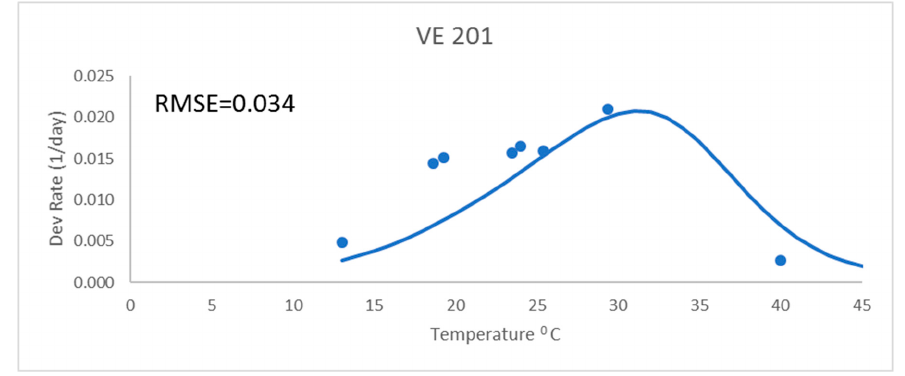
Figure 1. Poikilotherm equation with original parameters from Lehenbauer’s maize coleoptile elongation rate data, applied to the first variety (VE 201). RMSE indicates the root-mean-square error for the maize variety’s development rate. Table 2. Results with root-mean-square error (RMSE) for the published equations of Tonnang et al. [2] (Briere), with the Poikilotherm (Pk) equation [11] fit as described herein, for the heat stress equation fitted for just the first variety (Htstr), and for the heat stress fitted separately for each variety (Indiv fitted); also shown are Akaike’s Information Criterion (AIC), AICc, AICc differences ( Δ j AICc), and the derived Akaike weights ( ω j ) computed from the data. The Tbase is the x intercept for each equation that was fitted for each variety, as